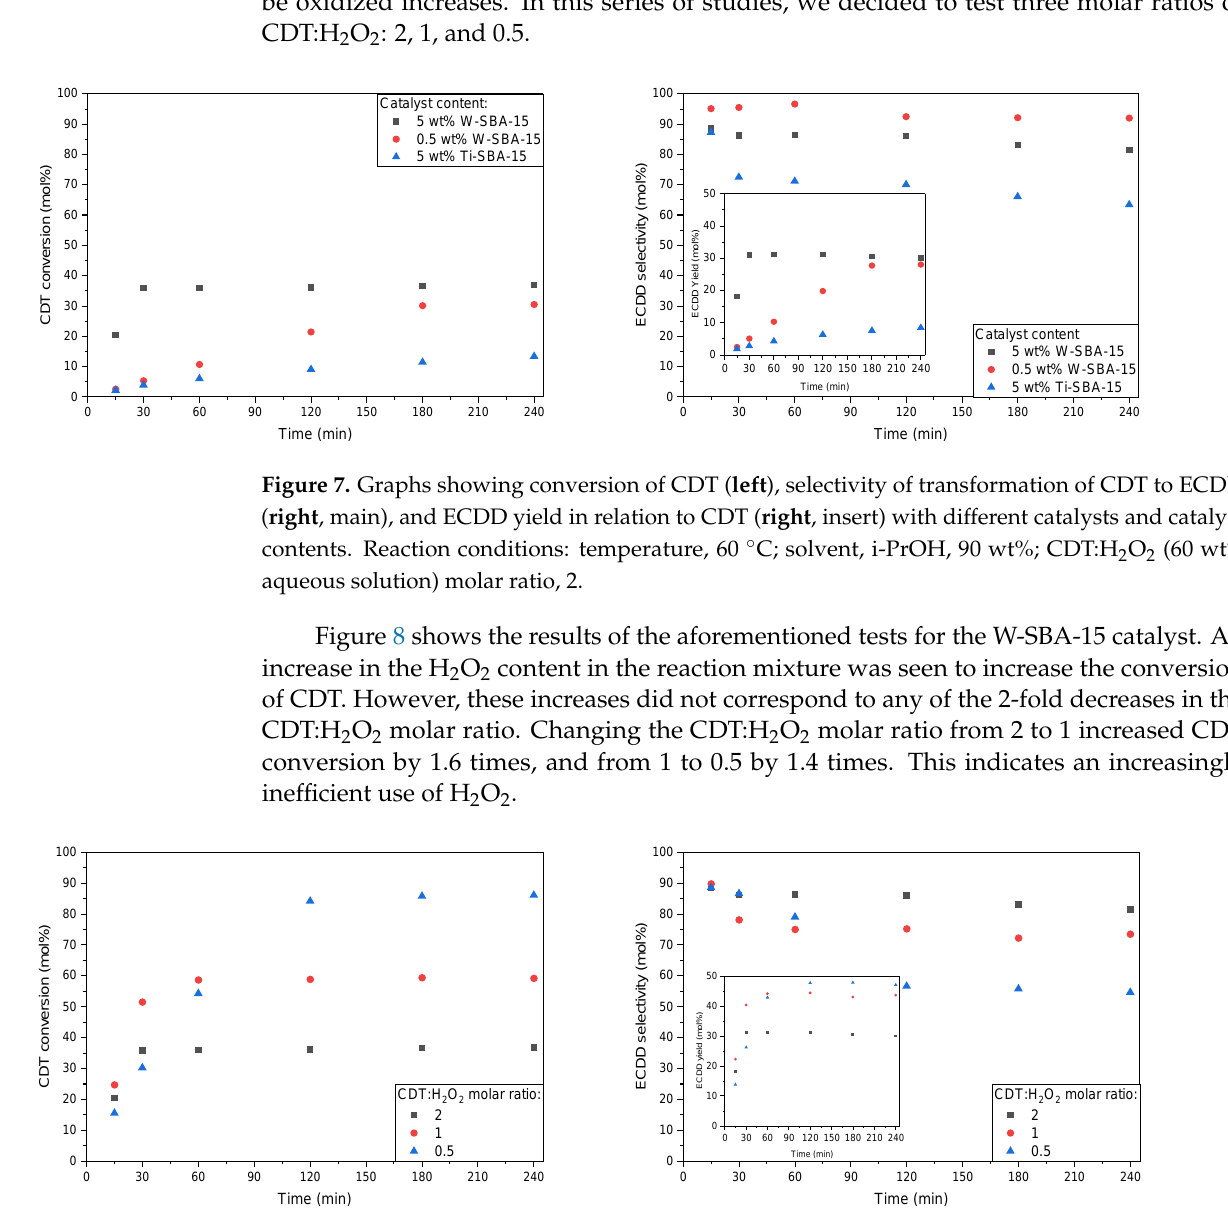
Figure 8. Graphs showing conversion of CDT ( left ), selectivity of transformation of CDT to ECDD ( right , main), and ECDD yield in relation to CDT ( right , insert) at different CDT:H 2 O 2 molar ratios. Process conditions: temperature, 60 °C; solvent, i-PrOH, 90 wt%; H 2 O 2 (60 wt% aqueous solution); catalyst content, 5 wt%.